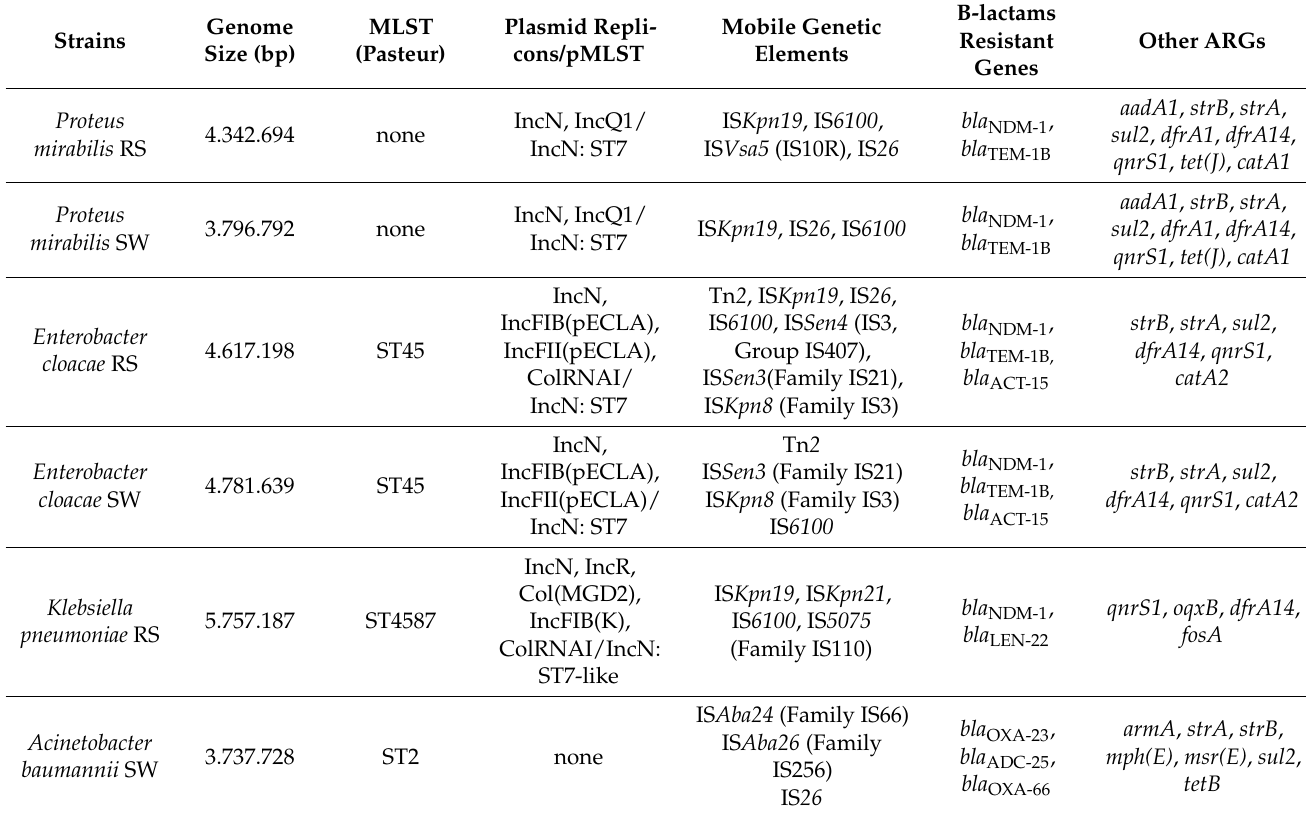
Table 2. Resistome of the six clinical strains isolated from surgical wound (SW) and rectal swab (RS) of a single